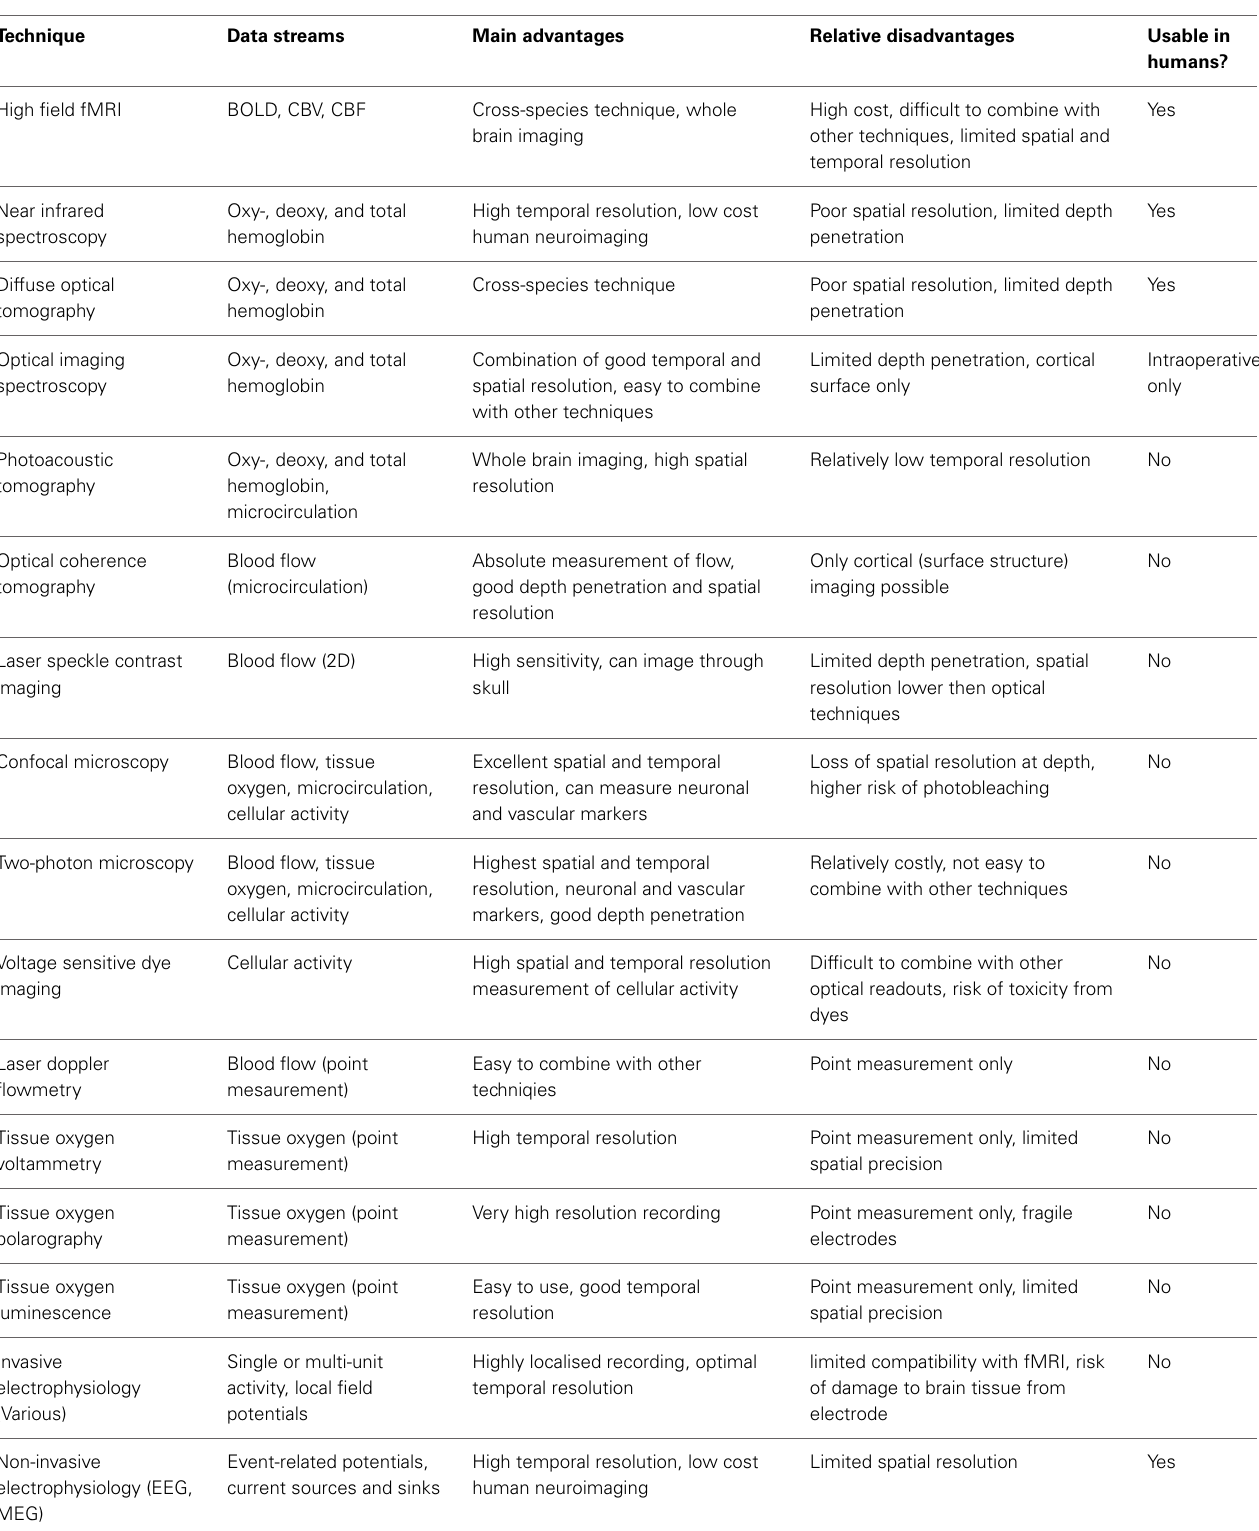
Table 1 | Overview of principle methods used to investigate neuroimaging signals and neurovascular coupling.